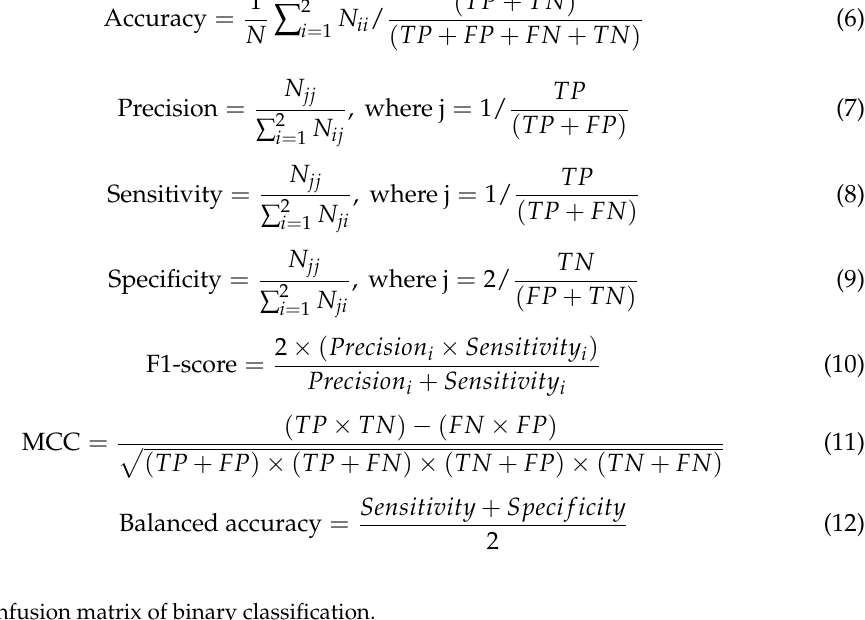
Table 6. Confusion matrix of binary